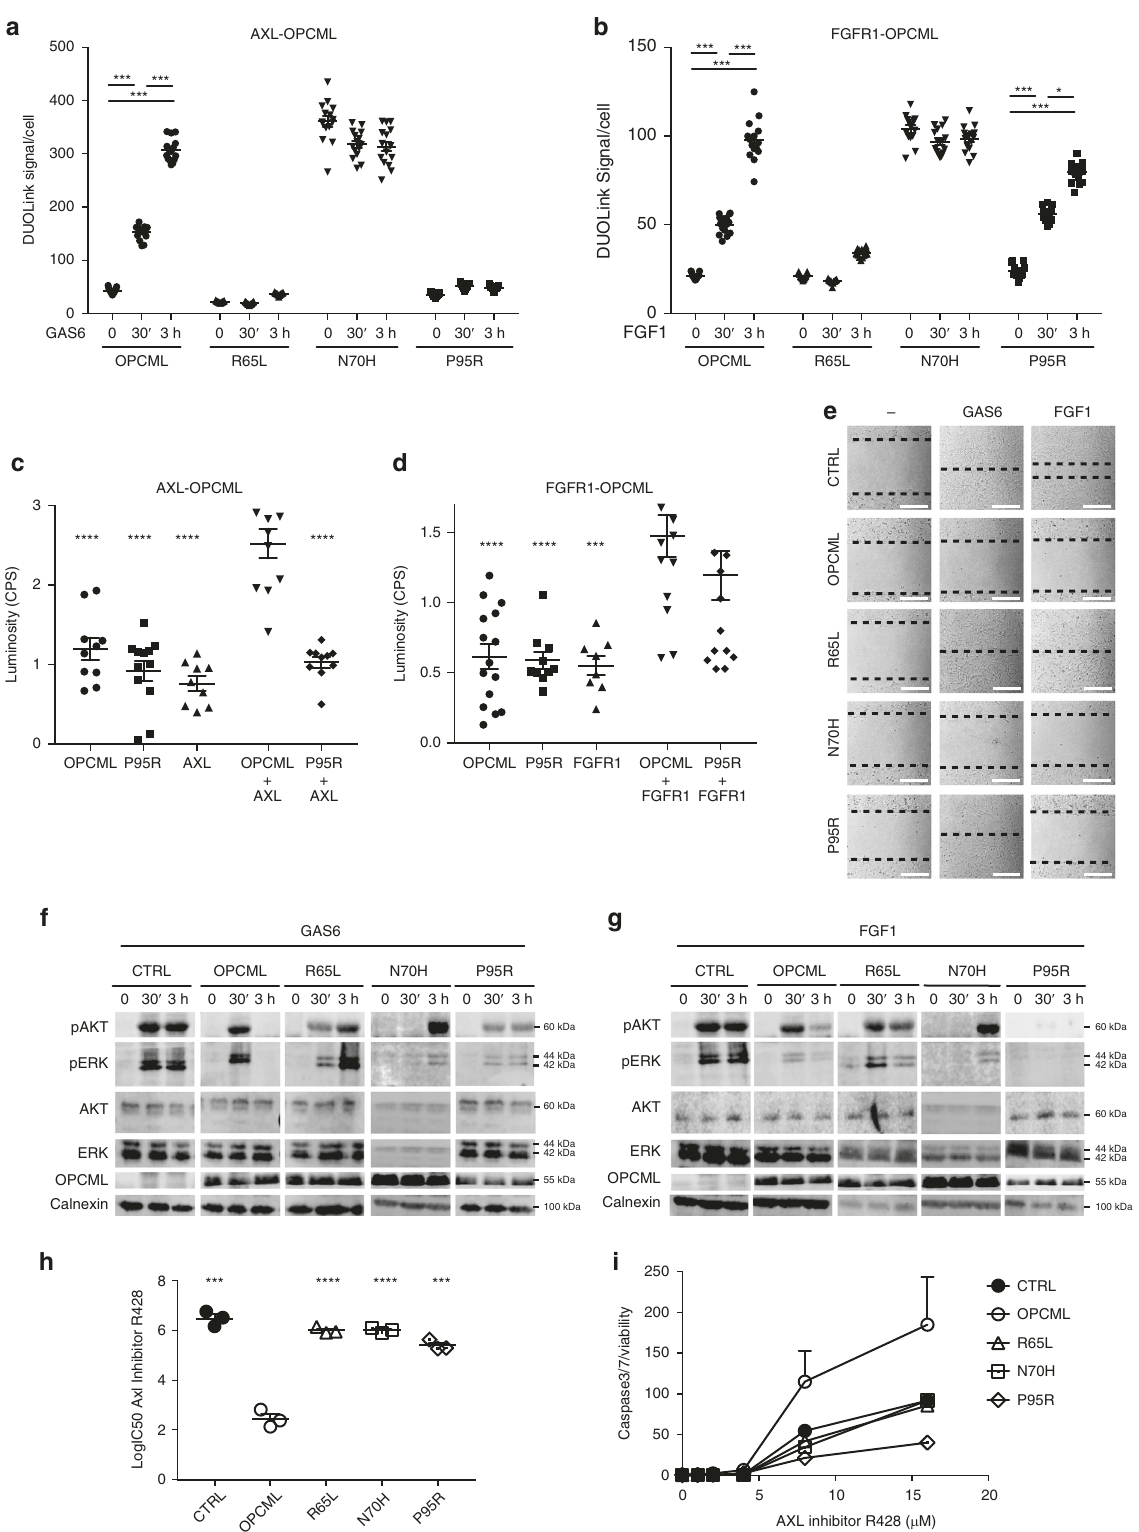
OPCML inhibits proliferation via its domains 2 and 3 . Since OPCML re-expression strongly decreases growth rate of cancer cells 2 , the whole panel of mutants in the three domains was tested in proliferation assays. Whereas D1 mutants did not lose the ability to inhibit proliferation, all mutants in D2 and D3